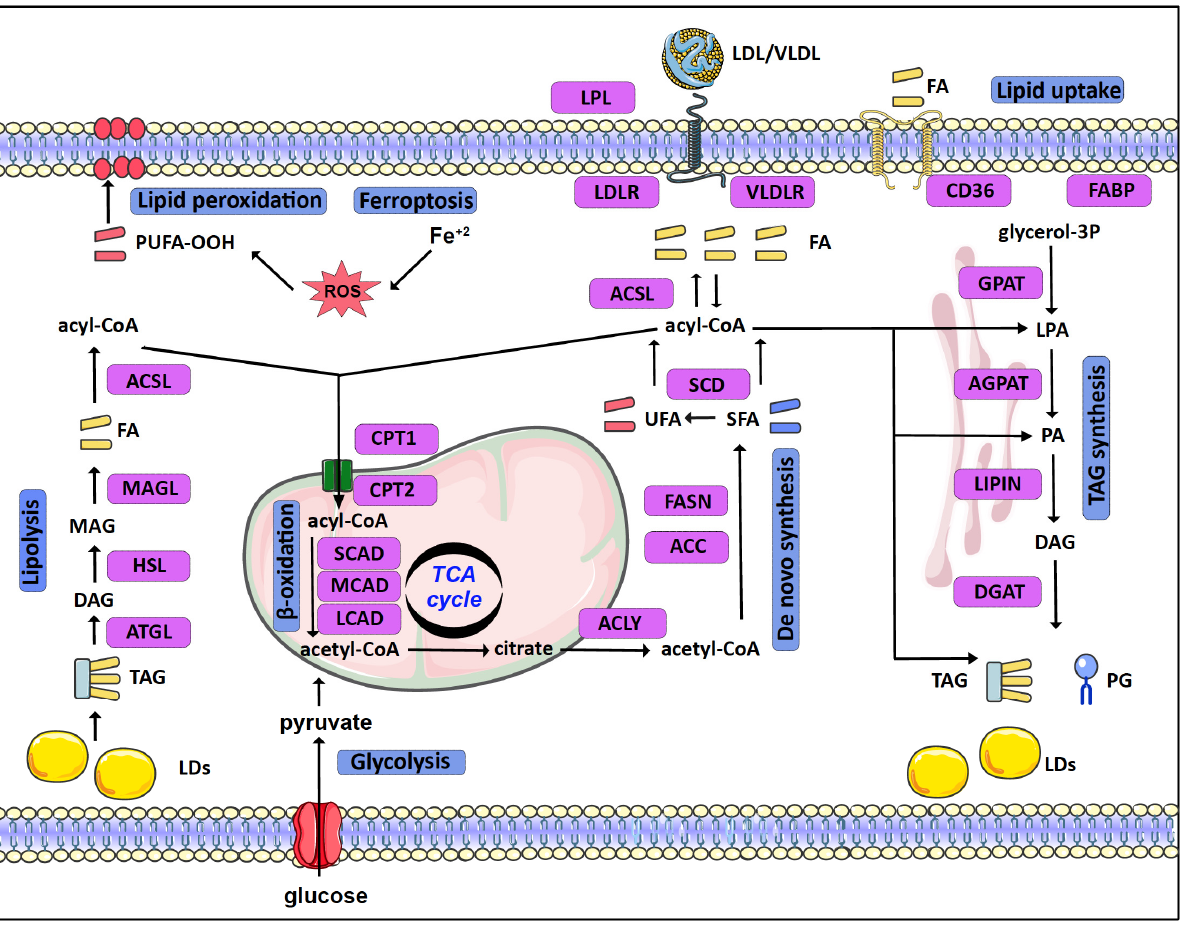
Figure 1. Schematic overview of lipid metabolism in normal as well as cancer cells. Lipid uptake of free fatty acids (FA: saturated, unsaturated, and/or polyunsaturated fatty acids) or Low-/Very-Low- Density Lipoproteins (LDL/VLDL) is facilitated by lipoprotein lipase (LPL), receptors (LDLR/VLDLR, CD36), and FA binding proteins (FABP). De novo synthesis, fueled by acetyl-CoA derived from citrate produced in the TCA cycle, creates saturated FA (SFA) and unsaturated FA (UFA). FAs in the form of acyl-CoA are used for the synthesis of triacylglycerides (TAG) and phosphoglycerides (PG) and stored in lipid droplets (LDs). LDs can be broken down to FAs by lipolysis. FAs, after conversion to acyl-CoA, can also be transported to mitochondria and broken down to acetyl-CoA by β -oxidation. The production and oxidation of polyunsaturated FA (PUFA) in the presence of Fe 2+ and oxidants (ROS) is directly related to cell death by ferroptosis. Lipid metabolism-related enzymes are shown as purple rectangles (see text for further details). (Abbreviations: PA (Phosphatidic Acid), Lysophosphatidic Acid (LPA), Diacylglycerol (DAG), Monoacylglycerol (MAG), short-chain acyl-coenzyme A dehydrogenase (SCAD), medium-chain acyl-coenzyme A dehydrogenase (MCAD), and long-chain acyl-coenzyme A dehydrogenase (LCAD)).